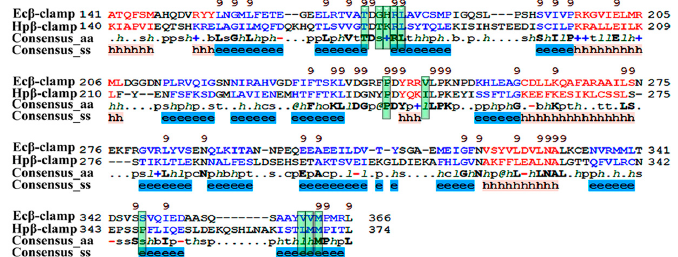
Figure 5. Structure-based sequence alignment. β -clamps of H. pylori and E. coli were compared using structure based sequence alignment. The ligand-interacting residues are highlighted (in green box). In each block, the first line shows conservation indices for positions with a conservation index above 5. The secondary structure prediction is shown in color red (alpha-helix) and blue (beta-strand). The last two lines show consensus amino acid sequence (consensus_aa) and consensus